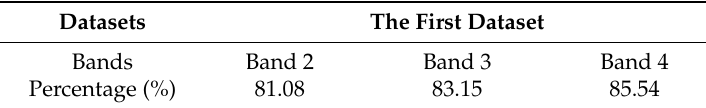
Table 2. The percentages of the squared error ( σ 2 the first